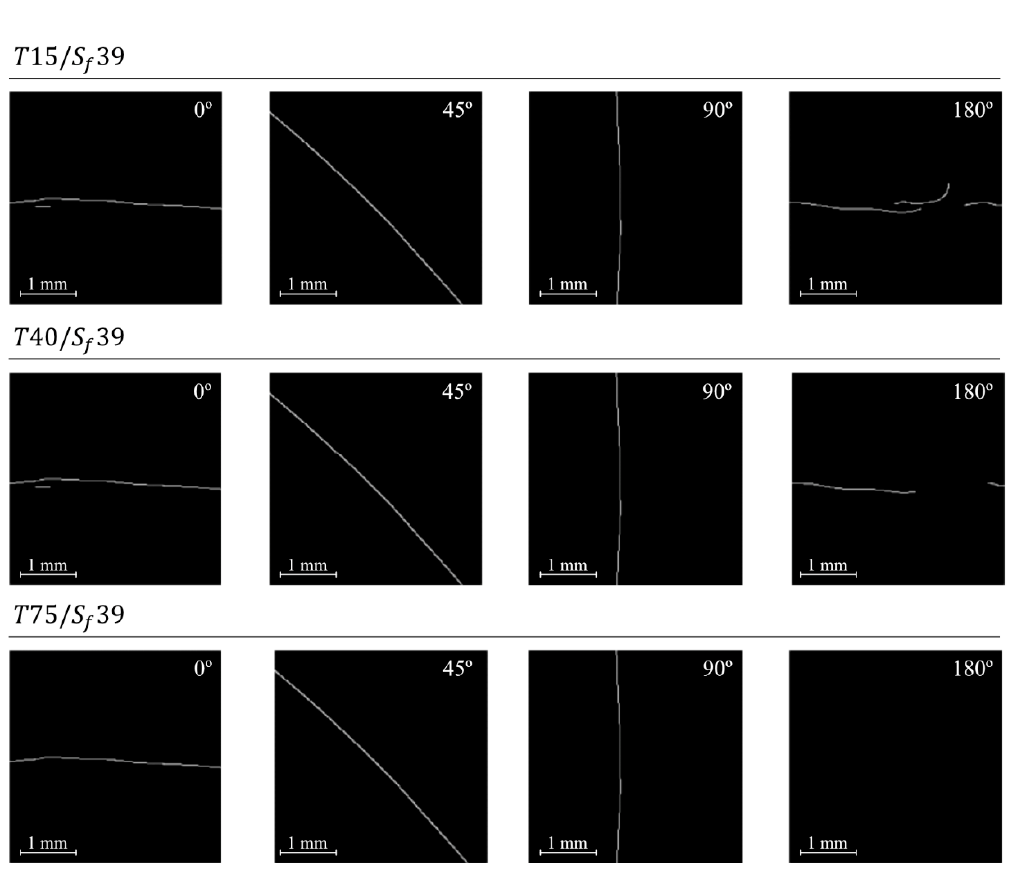
Figure 10. Samples of S 02 contour points obtained with Canny for different angular positions and test configurations: T 15/ S f 39 ( upper row ), T 40/ S f 39 and T 75/ S f 39 ( lower row